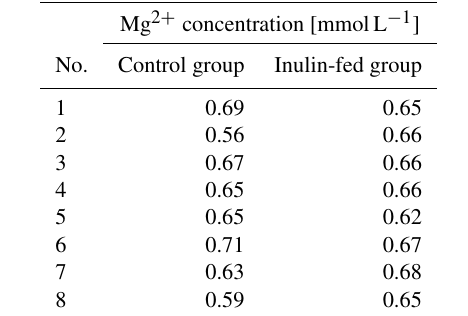
Table 1. Magnesium concentration in the blood plasma of the con- trol group and animals fed a diet supplemented with